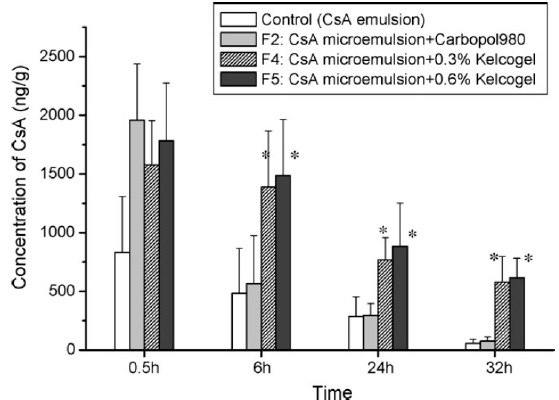
Figure 2. Concentration of cyclosporine A (CsA) in the cornea after the instillation of formulations (* p < 0.05) [59]. Reprinted from [59]. Copyright (2018), with permission from